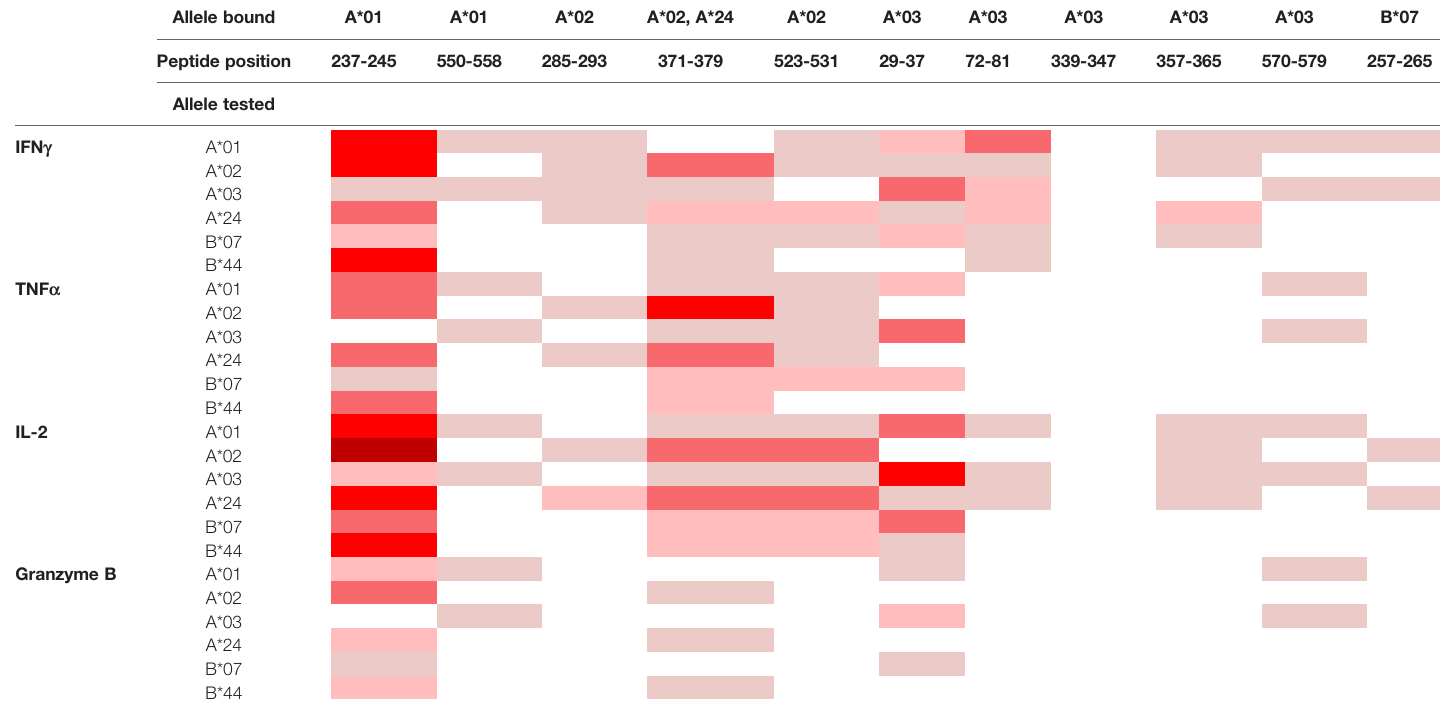
Individual peptides are identi fi ed at the top of the table. The speci fi c cytokine or protease measured is indicated on the left side of the table. The color intensity indicates the number of donors in each HLA type which responded tothe peptide and follows: 1 2 3 4 5-6